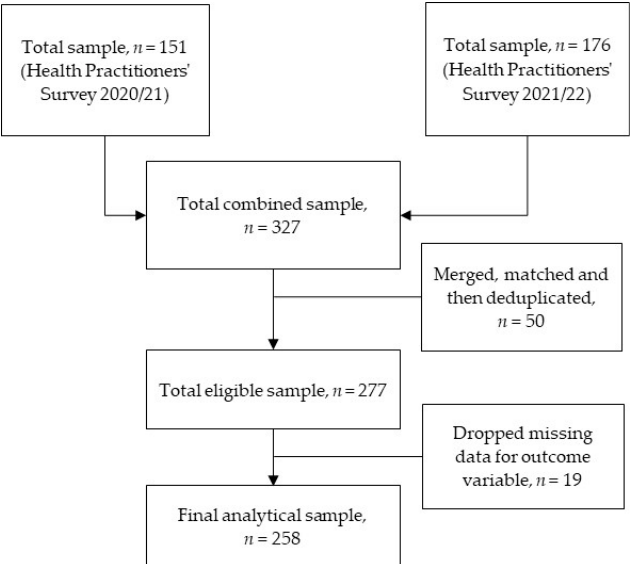
Figure 1. Flow diagram of sample selection.